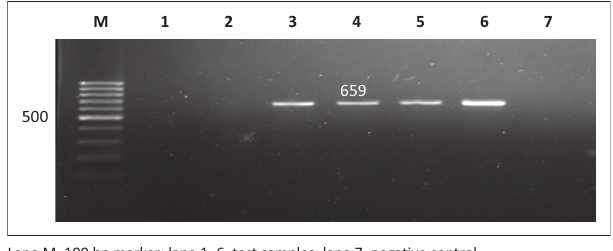
FIGURE 10: Detection of the 659 bp tet B gene amplicon from four representative Salmonella isolates by agarose gel electrophoresis.